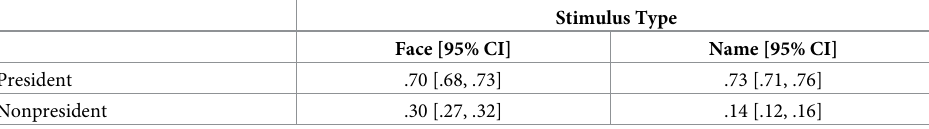
Table 5. Mean hit and false alarm rates for responding “president” to a name versus to an image in Experiment